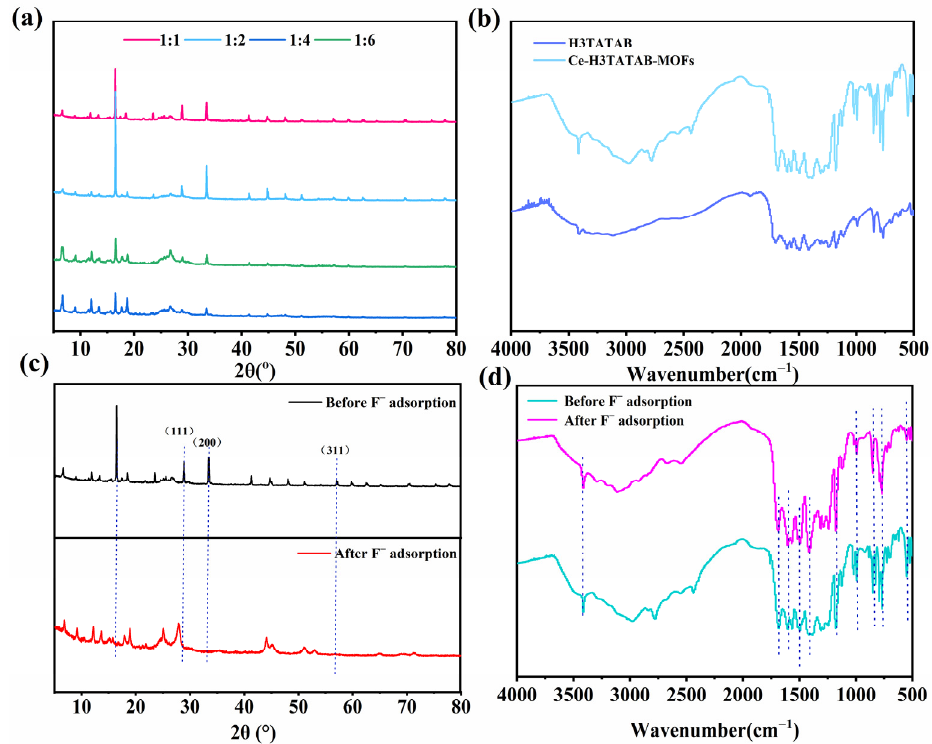
Figure 2. ( a ) XRD fi gures at di ff erent molar ratios; ( b ) FTIR spectra of H3TATAB and Ce-H3TATAB- MOF; ( c ) XRD fi gures of Ce-H3TATAB-MOFs before and after adsorption; ( d ) FTIR spectra of Ce- MOF; ( c ) XRD figures of Ce-H3TATAB-MOFs before and after adsorption; ( d ) FTIR spectra of H3TATAB-MOFs before and after fl uoride removal. Ce-H3TATAB-MOFs before and after fluoride